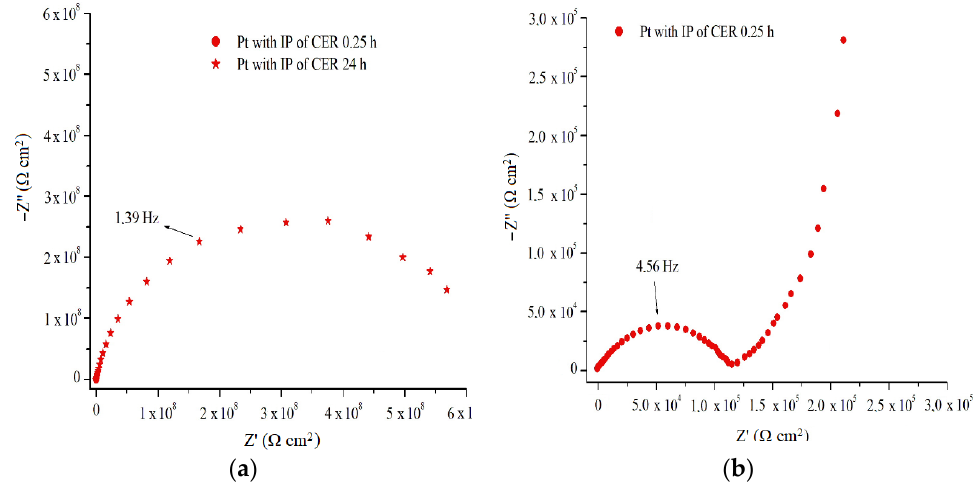
Figure 12. EIS in representation of Nyquist for coated Pt with IP of CER after ( a ) 0.25 h and 24 h; ( b ) 0.25 h of immersion in 2 mol L −1 H 2 SO 4 solution.